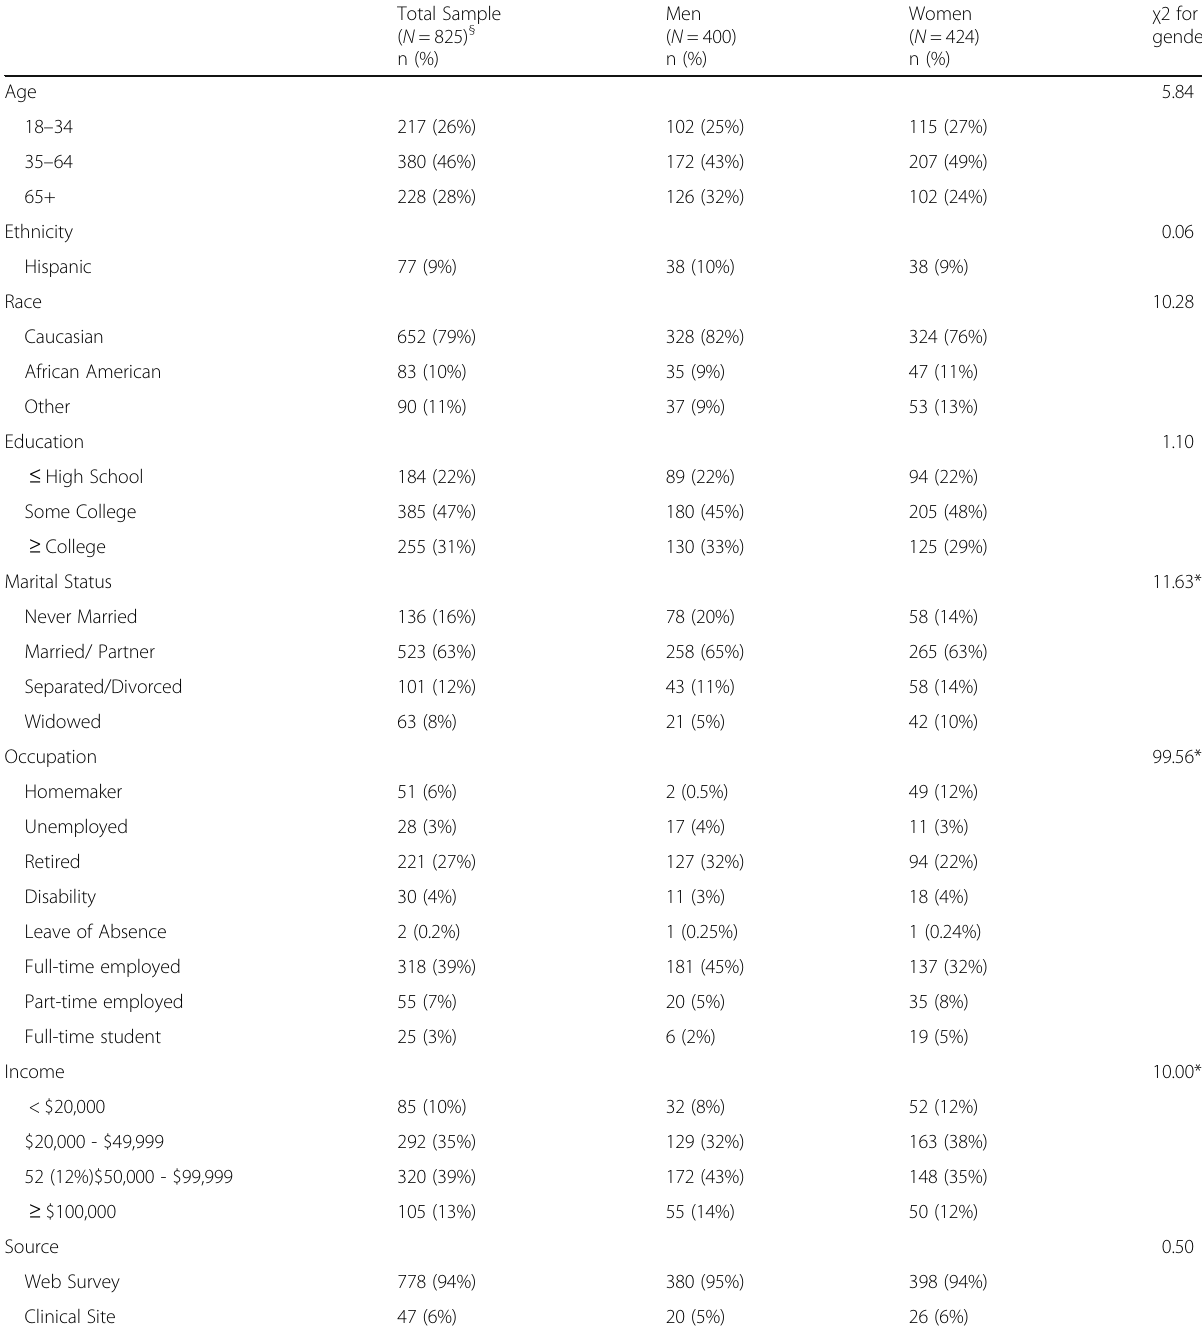
Table 1 Sociodemographics of the PROMIS® Wave 1